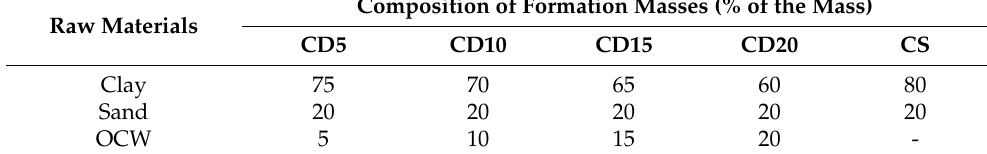
Table 1. Forming mass